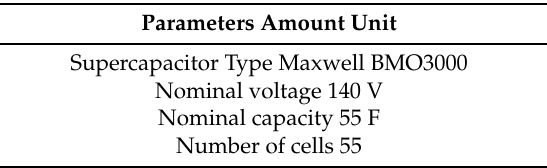
Table 4. Electrical parameters of the supercapacitor.